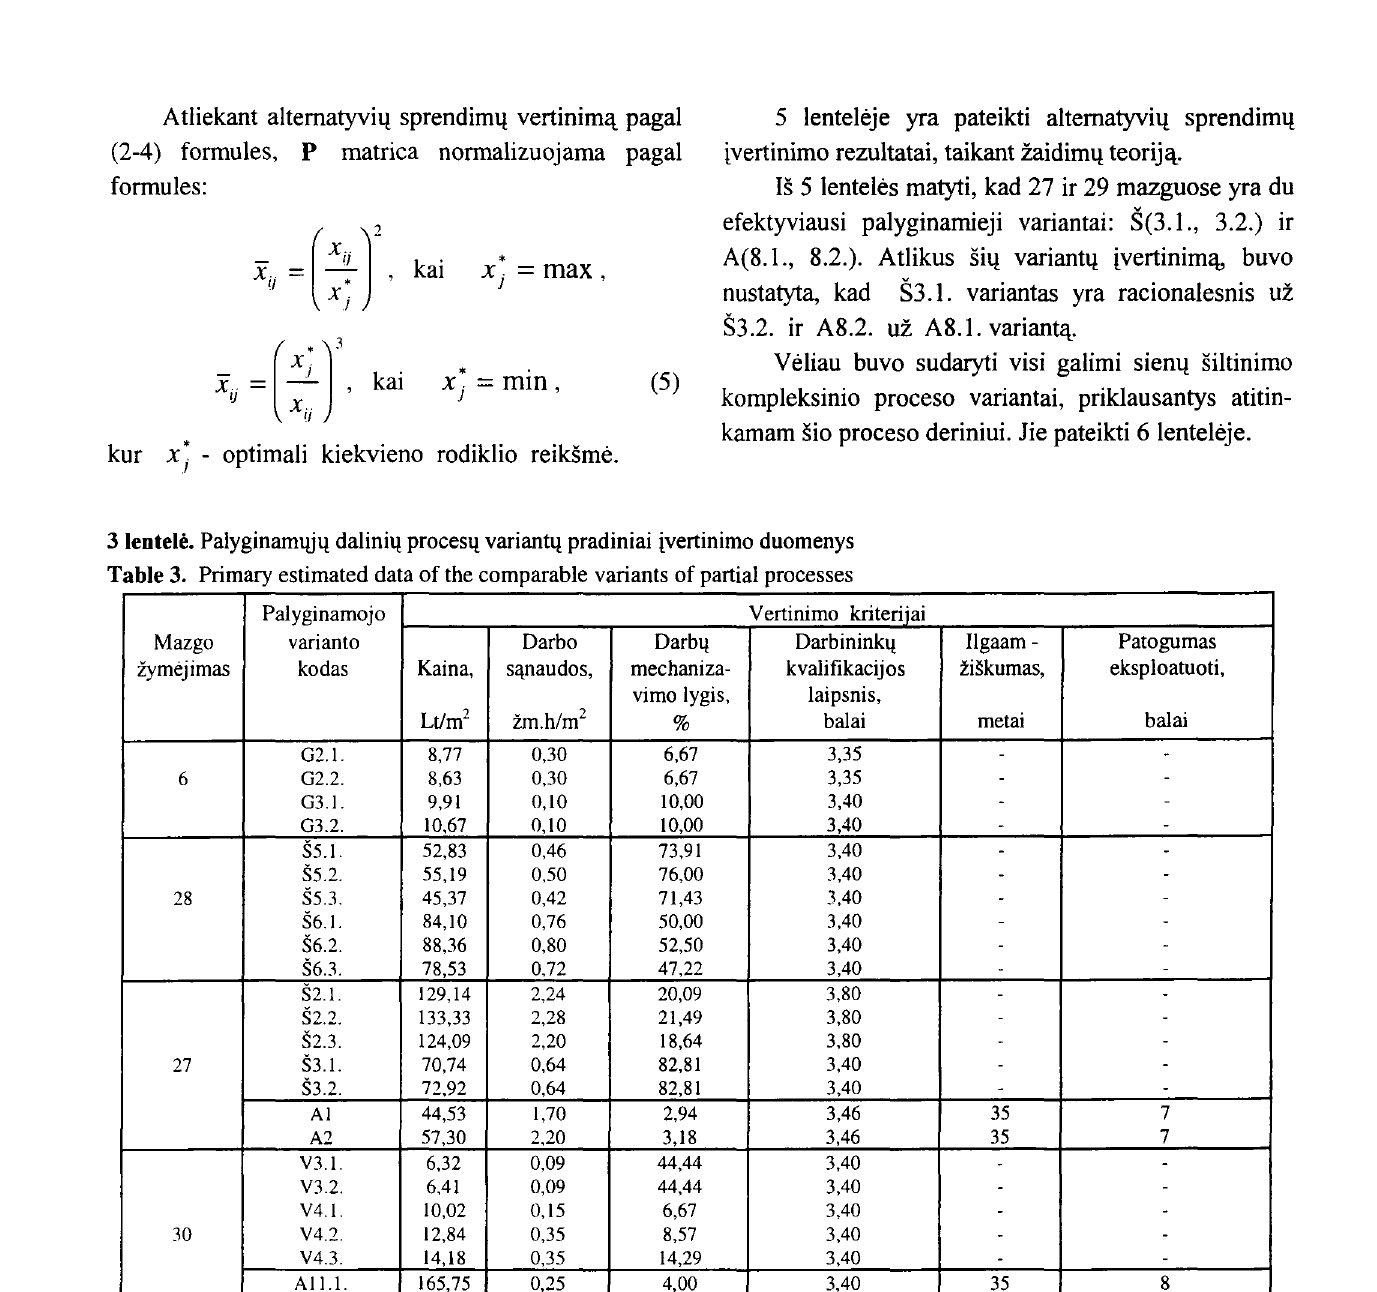
Table 3. Primary estimated data of the comparable variants of partial processes Palyginamojo Vertinimo kriterijai Mazgo varian to Darbo Darb4 Darbinink4 Ilgaam- Patogumas zymejimas